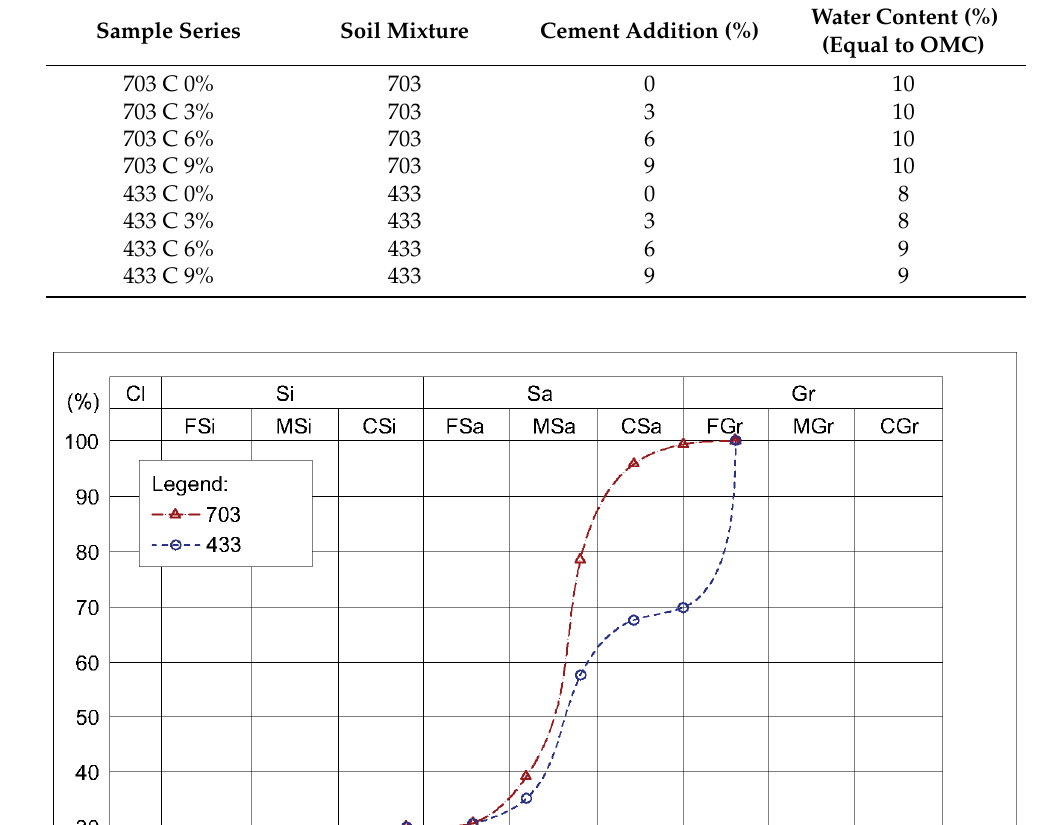
Table 2. Sample series used in the tests.